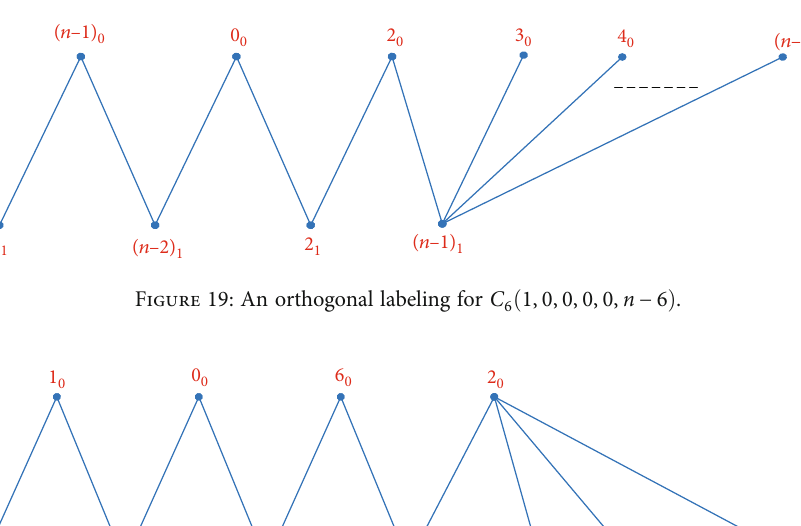
ð 1, 0, 0, 0, n − 5 Þ . 5